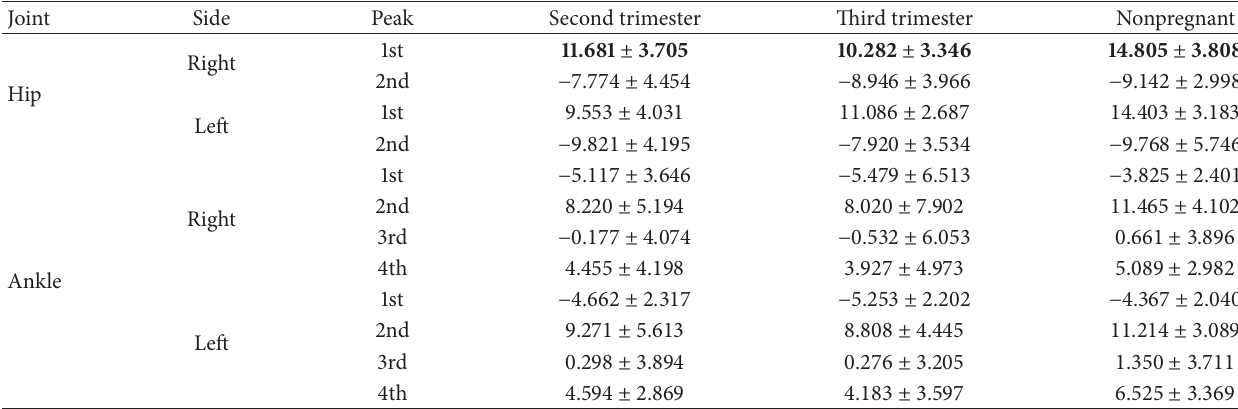
Table 3: Joint kinematic peak values (mean) of gait in the frontal plane, during the second and third trimesters of pregnancy ( 𝑁 = 22 ) and nulliparous controls ( 𝑁 = 12 ). Units (mean ± sd) are in degrees.